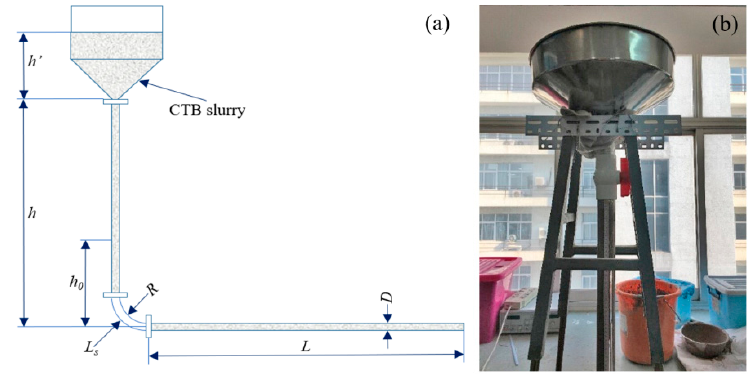
Figure 5. L ‐ shaped tube experimental device: ( a ) schematic diagram; ( b ) physical model. Figure 5. L-shaped tube experimental device: ( a ) schematic diagram; ( b ) physical